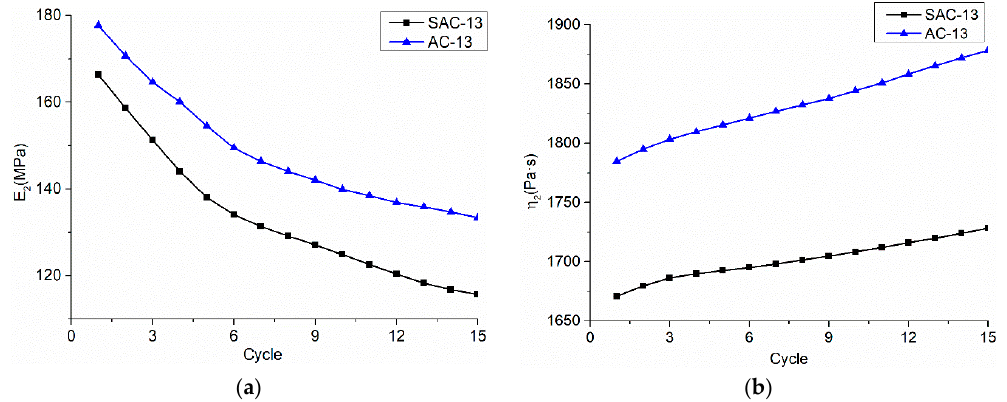
Figure 13. Viscoelastic parameters change with the load cycle times; ( a ) E 2 change with the load cycle times; and, ( b ) η 2 change with the load cycle times.